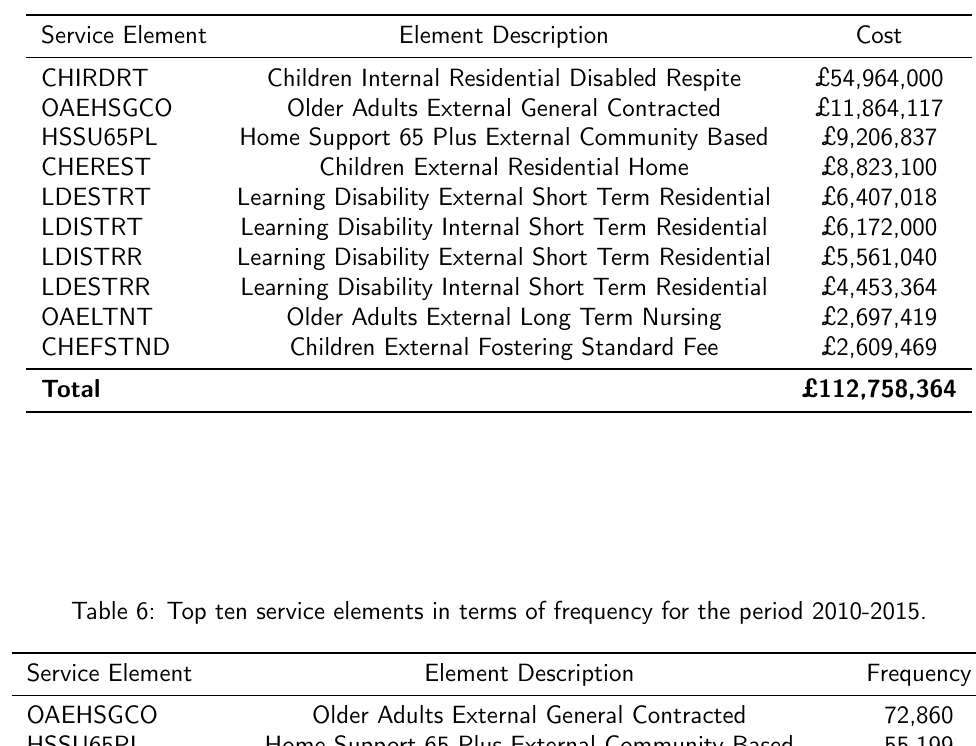
Table 5: Top ten service elements in terms of cost for the period 2010-2015.